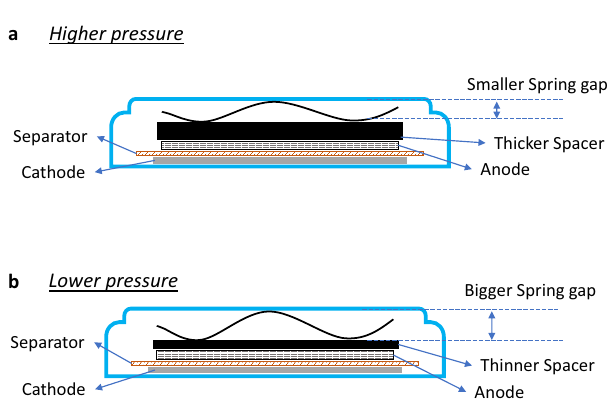
Fig. 2 Cross-section scheme of coin format cell with different internal pressures, assuming all components are the same except for different spacer thickness. a Higher internal pressure with bigger spring compression due to thicker spacer and resulting smaller spring gap; b Lower internal pressure with smaller spring compression due to thinner spacer and resulting bigger